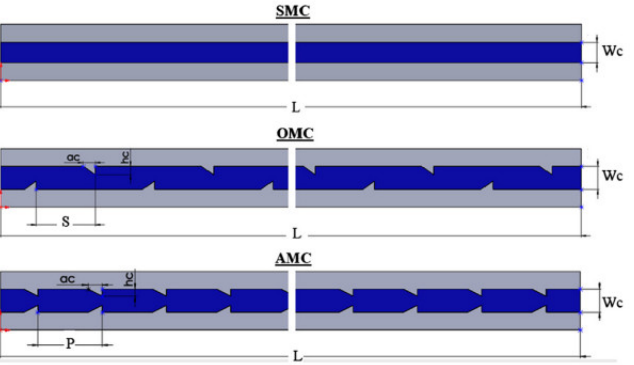
Figure 33. Cross-section through smooth microchannel (SMC), offset ribs microchannel (OMC), and aligned ribs Microchannel (AMC) [137]. Reprinted with permission from Ref. [137]. 2018, Elsevier.